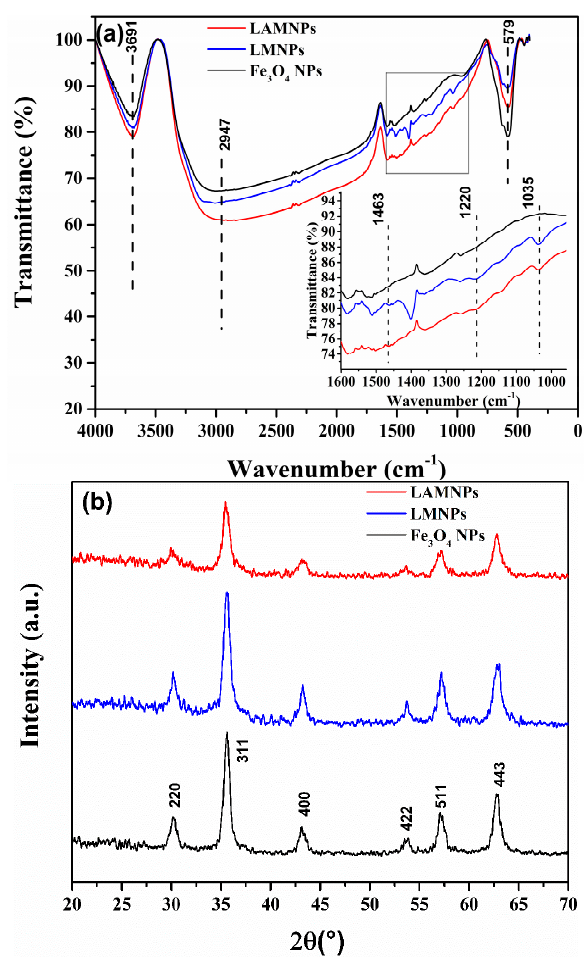
Figure 4. ( a ) FT-IR spectrum of LAMNPs (red), LMNPs (blue) and MNPs (black); and ( b ) XRD patterns of LAMNPs (red), LMNPs (blue) and MNPs (black). The insert in ( a ) is the enlargement of the gray rectangular region.